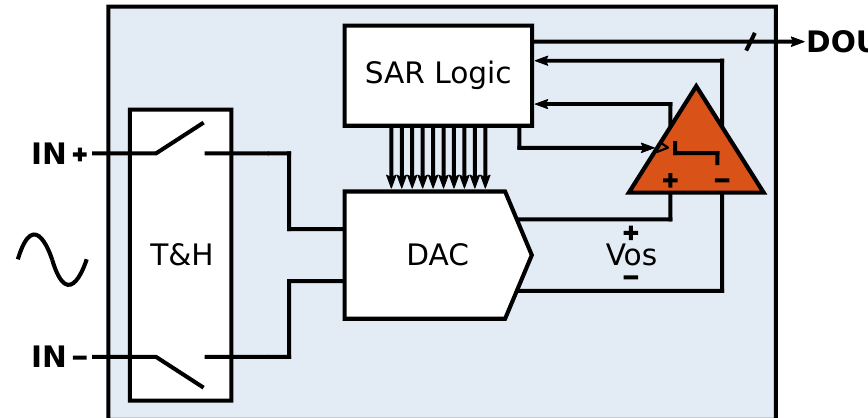
Figure 1. Top-level SAR ADC block diagram with its Track-and-Hold (T&H), DAC, comparator and SAR logic. A low-offset ( V OS ), low-noise, and high-speed comparator determines the total performance and the accuracy on the output data